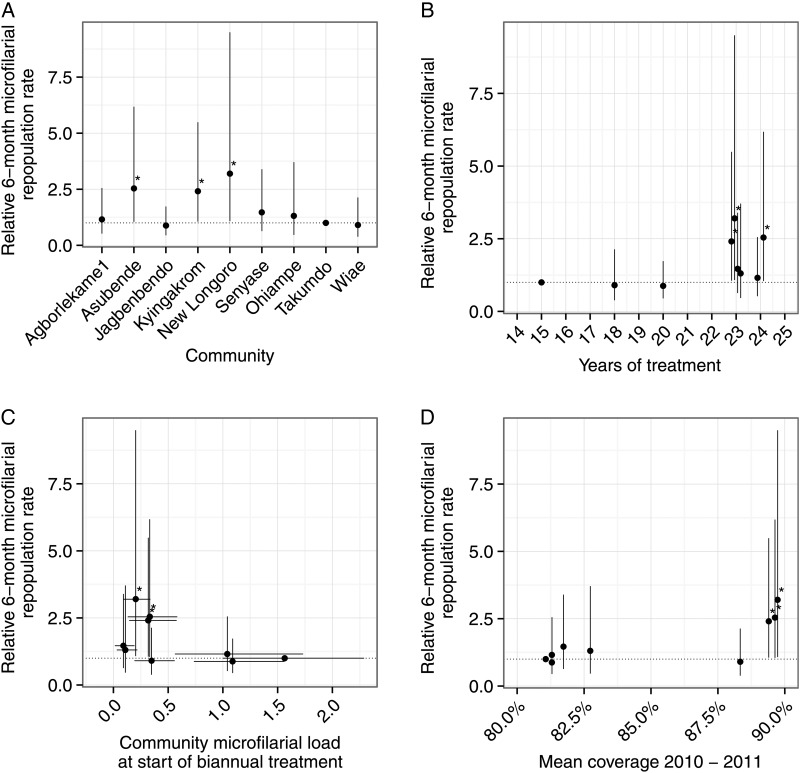
Relative 6-month microfilarial repopulation rates in 10 Ghanaian communities over the first 2 rounds of a biannual ivermectin treatment strategy. Data points represent the estimated relative (multiplicative) 6-month microfilarial repopulation in each community compared with Takumdo. Six-month repopulation rates are defined as mean microfilarial loads 6 months after a round of ivermectin treatment, expressed as a percentage of the microfilarial load estimated just before the preceding treatment round. Estimates are derived from Model 2, Table 2, which treats time since the preceding ivermectin treatment as a continuous covariate interacting with the indicator covariate for community. The 6-month microfilarial repopulation rate from Baaya is not shown because only 1 participant was microfilaria positive (Table 1), leading to very large associated estimates of uncertainty. A, Estimates are plotted side-by-side for the different communities. B, Estimates are plotted against the number of years of ivermectin treatment preceding the biannual strategy. C, Estimates are plotted against community microfilarial load (CMFL) preceding the first biannual ivermectin treatment. D, Estimates are plotted against the mean coverage of ivermectin distribution for the years 2010 and 2011, corresponding to the component of the study when the longitudinal cohort of participants was followed up over 2 consecutive rounds of biannual treatment (see also Supplementary Figure A for disaggregated coverage data from 2005 to 2013). Vertical lines are 95% confidence bounds, calculated using robust sandwich estimators of coefficient standard errors (Supplementary Methods). Solid horizontal lines in (C) indicate 95% confidence bounds associated with the estimated CMFL, calculated using a numerical bootstrap resampling method (Supplementary Methods). *P < .05, comparing with the reference village of Takumdo.